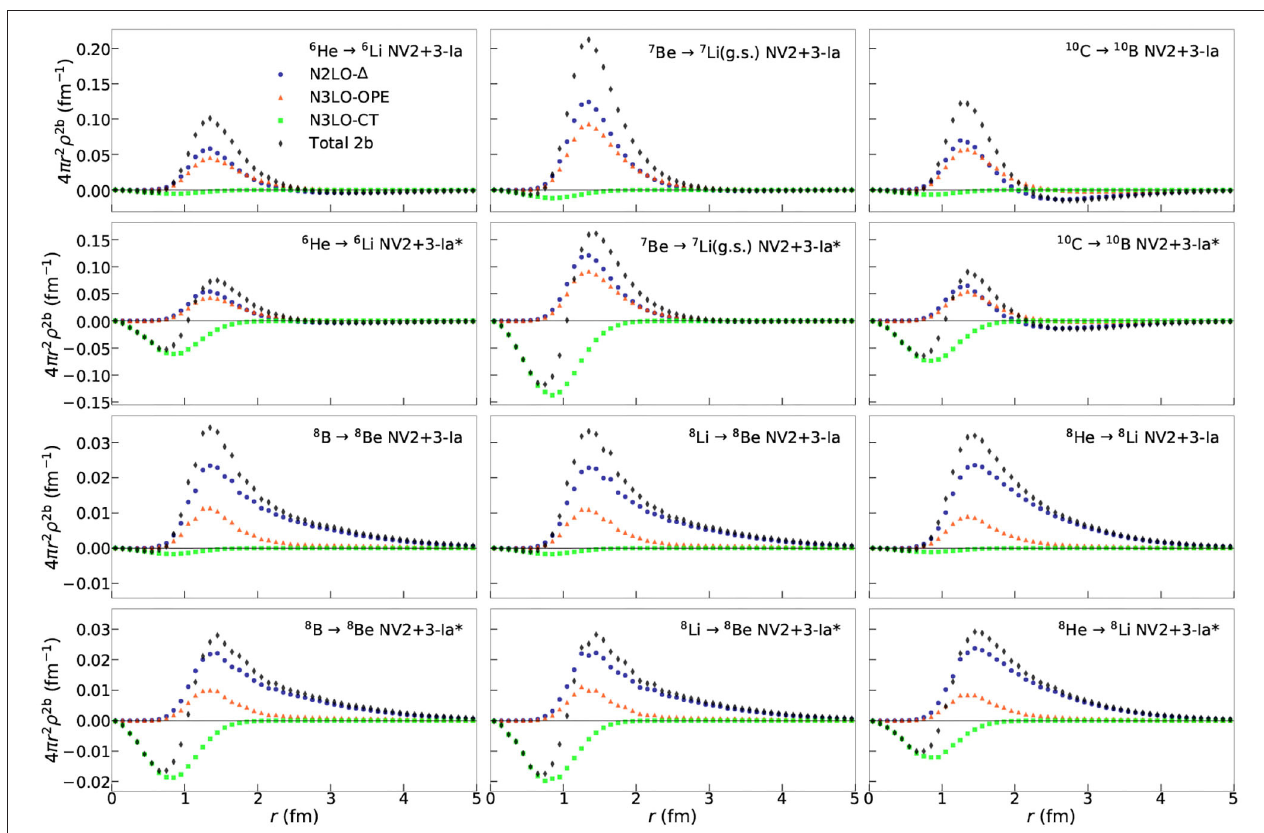
FIGURE 4 | Two-body density as defined in Equation (13) for GT RMEs obtained using the NV2+3-Ia/Ia* models for select nuclei.